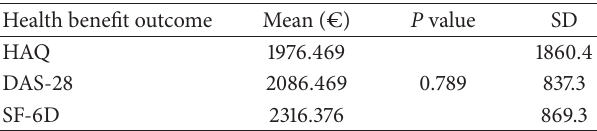
Table 6: Statistical analysis between the choice of health outcome used to express